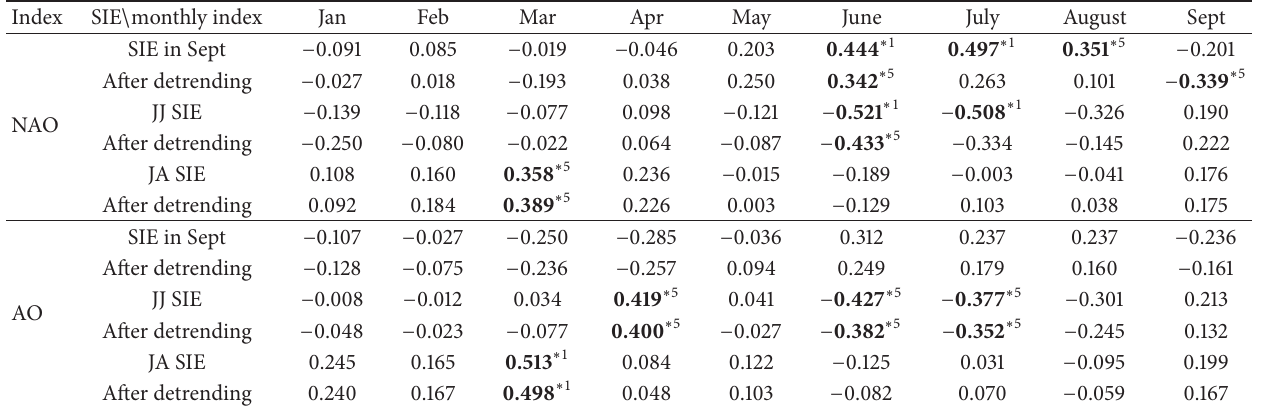
Figure 9: The anomalies at SLP and 500 hPa HGT in July and August for 2007 and 2012 cases: (a) the July SLP anomaly in 2007 relative to the 30 yr (1981–2010) average July SLP, (b) as in (a) but for 2012, (c) the August SLP anomaly in 2007 relative to the 30 yr (1981–2010) average August SLP, (d) as in (c) but for 2012, (e) the July 500hPa GHT anomaly in 2007 relative to the 30 yr (1981–2010) average July 500 hPa GHT, (f) as in (e) but for 2012, (g) the August 500hPa GHT anomaly in 2007 relative to the 30 yr (1981–2010) average August 500hPa GHT, and (h) as in (g) but for 2012. Table 3: Correlation analyses of the September SIE, the JJ and JA SIE with monthly NAO and AO index from 1979 to 2012. Note: correlation coefficients higher than 0.339 and 0.435 are defined as confidence levels at 95% ( ∗ 5) and 99% ( ∗ 1),